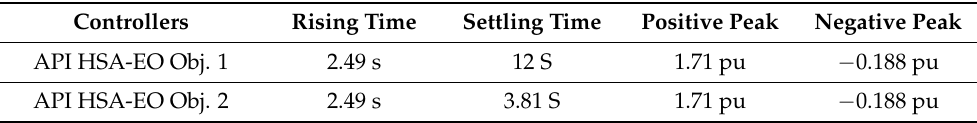
Table 13. Numerical comparison between the controllers at faulty second Table 14. Statistical analysis of the active power—faulty second case.